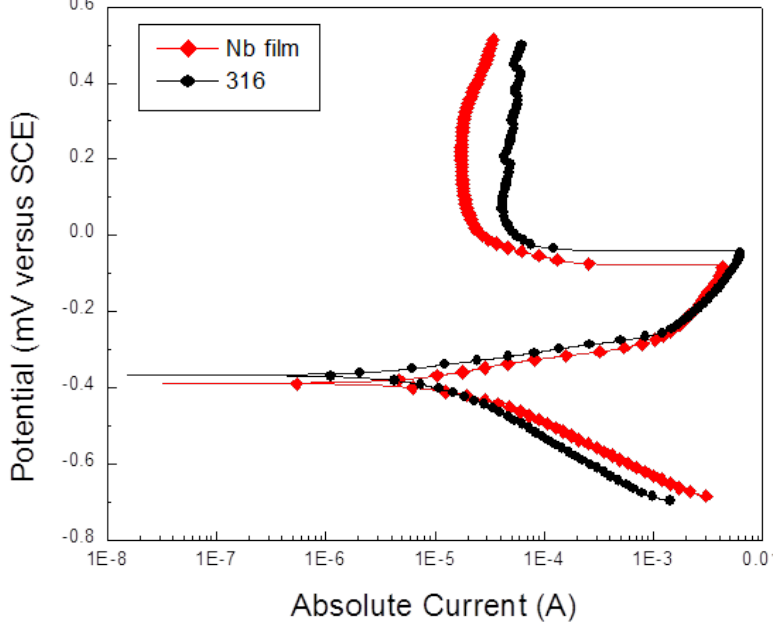
Figure 4. Potential-current curve of the Nb films as compared to the 316L steel